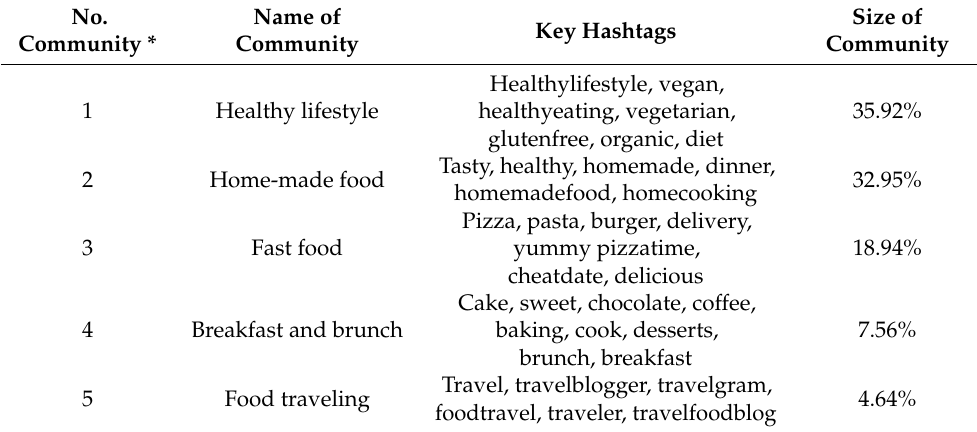
Table 5. Communities detected in connection with the hashtag #foodblogger on